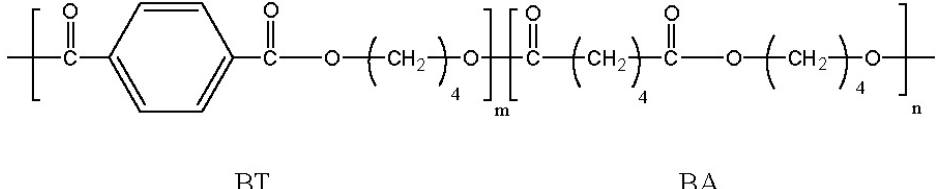
Figure 7. Chemical structure of poly(butylene adipate- co -terephthalate) showing the rigid and flexible moieties derived from terephthalic and adipic units,